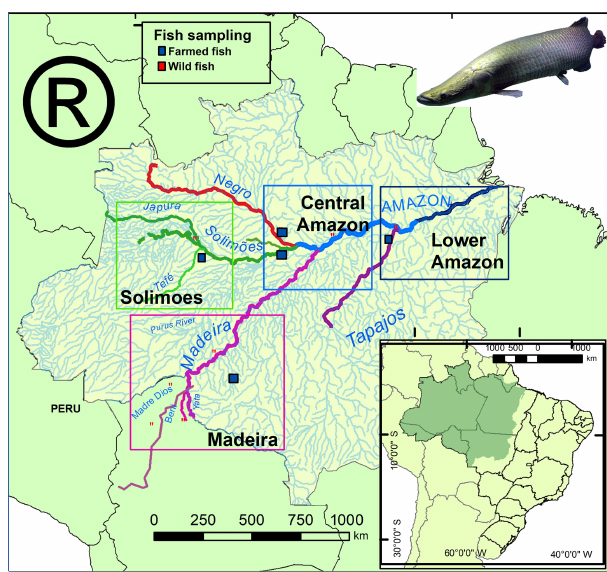
Figure 1. Map of the Amazon basin showing the regions and sam- pling sites for Arapaima spp. Wild collection sites are represented by red squares and farm collected sites by blue squares. The Ama- zon River (Lower Amazon and Central Amazon) is colored blue, the Solimões green, the Madeira purple, Tapajós purple, and the Negro